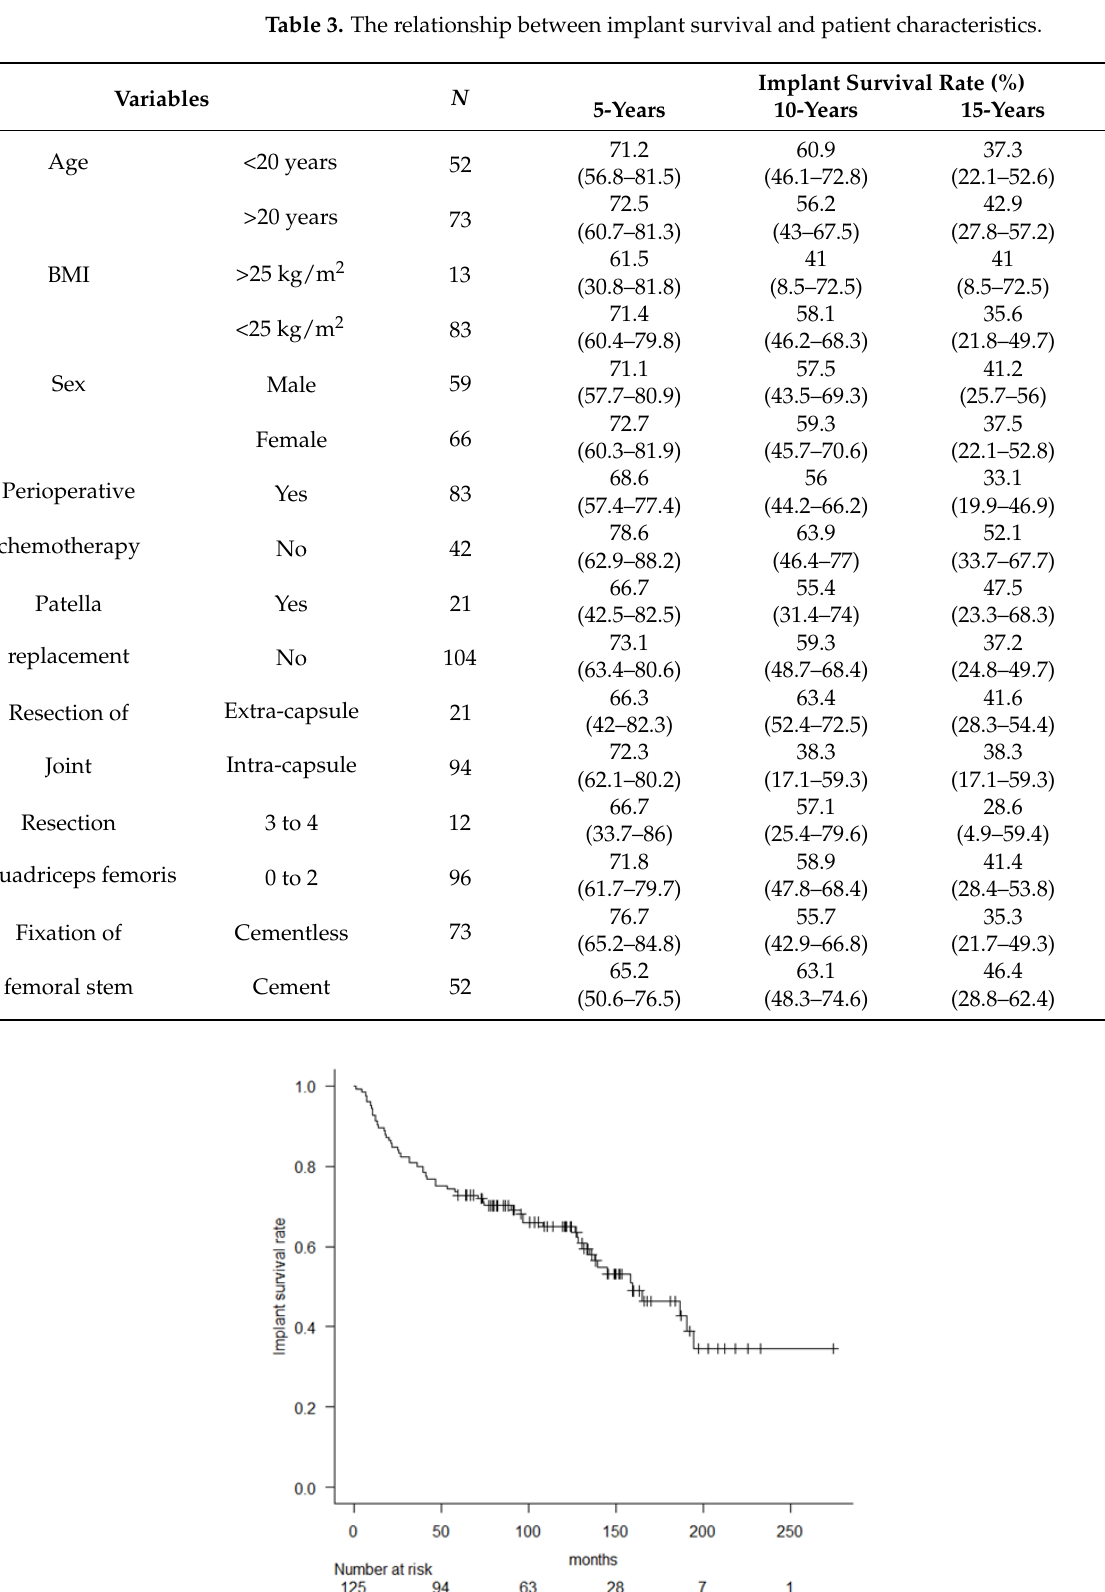
( p = 0.71) (Figure 4). Figure 4. Kaplan–Meier curve comparing patients with cement ( A ) and cementless ( B ) femoral stem fixation. There was no significant variable to predict major revision, although the administra- tion of perioperative chemotherapy was a marginally significant variable ( p = 0.06). The 5- , 10-, and 15-year implant survival (major revision) in 83 patients with perioperative